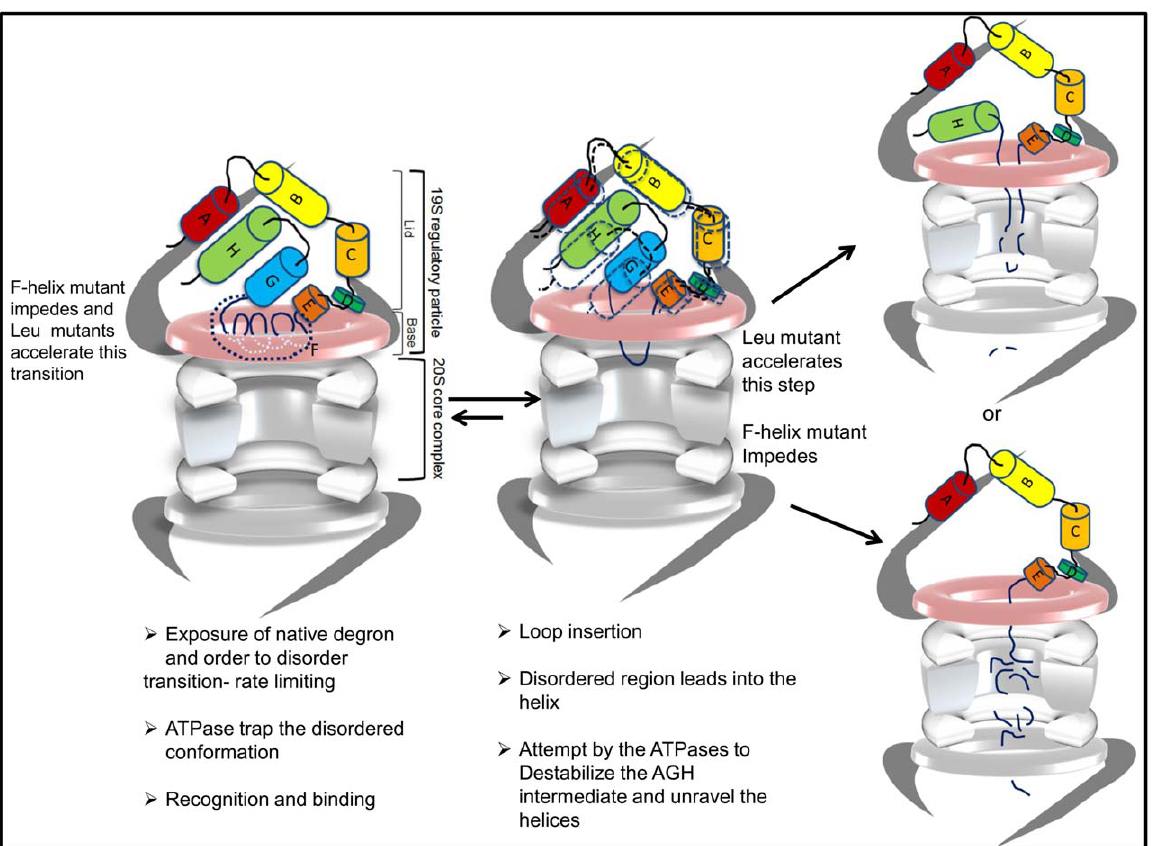
Figure 7. A model for the mechanistic steps involved in the degradation of apoMb based on structural changes in mutations used as snap shots. Removal of heme exposes a previously buried F-helix which is in a dynamic equilibrium between a partially folded and unfolded structure. This transition is a rate limiting step. Exposure of this floppy helix sensitizes the proteasome to the presence of the substrate. ApoMb is anchored to the proteasome by interactions primarily through the A-helix. Additional interactions stabilize the enzyme-substrate complex. Degradation is primed by the insertion of the floppy helix in the form of a loop into the central channel that runs across the proteasome. An intermediate composed of AGH helices is likely to be formed. Melting of this intermediate by the ATPases to generate an unstructured region long enough to reach the active site is a likely rate limiting step. Mutations can stabilize or destabilize this unfolding intermediate affecting the rate of